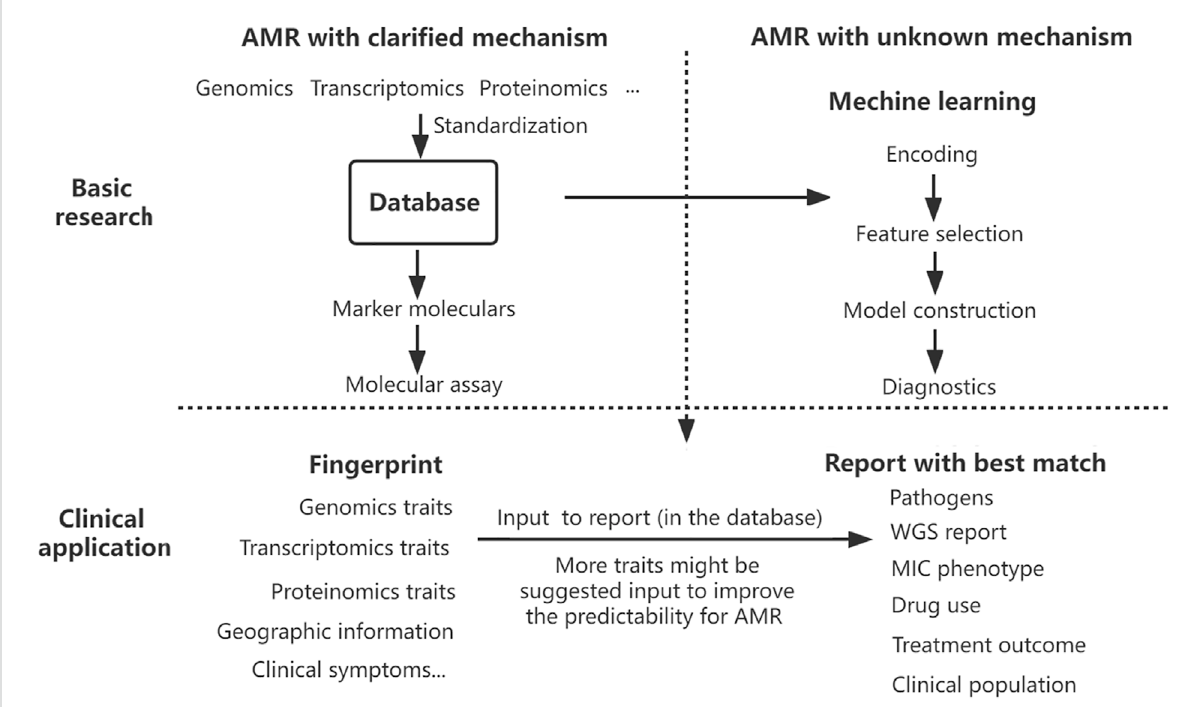
FIGURE 1 ProposedAMRsurveillancemodel.Variousdataonantibioticresistancehavebeencollectedintothedatabase,whichprovidesmarkermoleculesto detect AMR with clari fi edmechanism and fuels themodel training ofmachine learning to predict the AMR with an unknown mechanism. The results of rapidmoleculardetectiononmulti-traitsandotherinformationhelp fi ngerprintthepathogens,andthedatabaseinterfacewillreportthebestmatchedor advisedtreatmentdecisiondirectly.Takingadvantageoftherapidityofmolecularassaysandtheprecisionofmachinelearningfueledbyaconstant fl ow of multi-dimensional data, the AMR surveillance platform optimizes drug selection, antimicrobial stewardship, and epidemiological